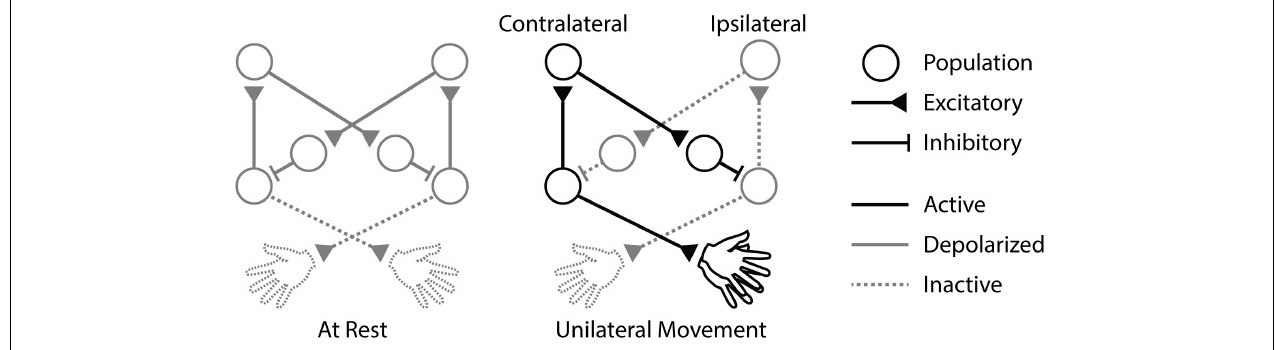
FIGURE 1 | Cortical circuitry during unilateral movement. When the animal is at rest, baseline interhemispheric inhibition (IHI) between the motor cortices is depolarized. Unilateral movement activates the contralateral cortex, triggering IHI to the ipsilateral cortex and disinhibiting